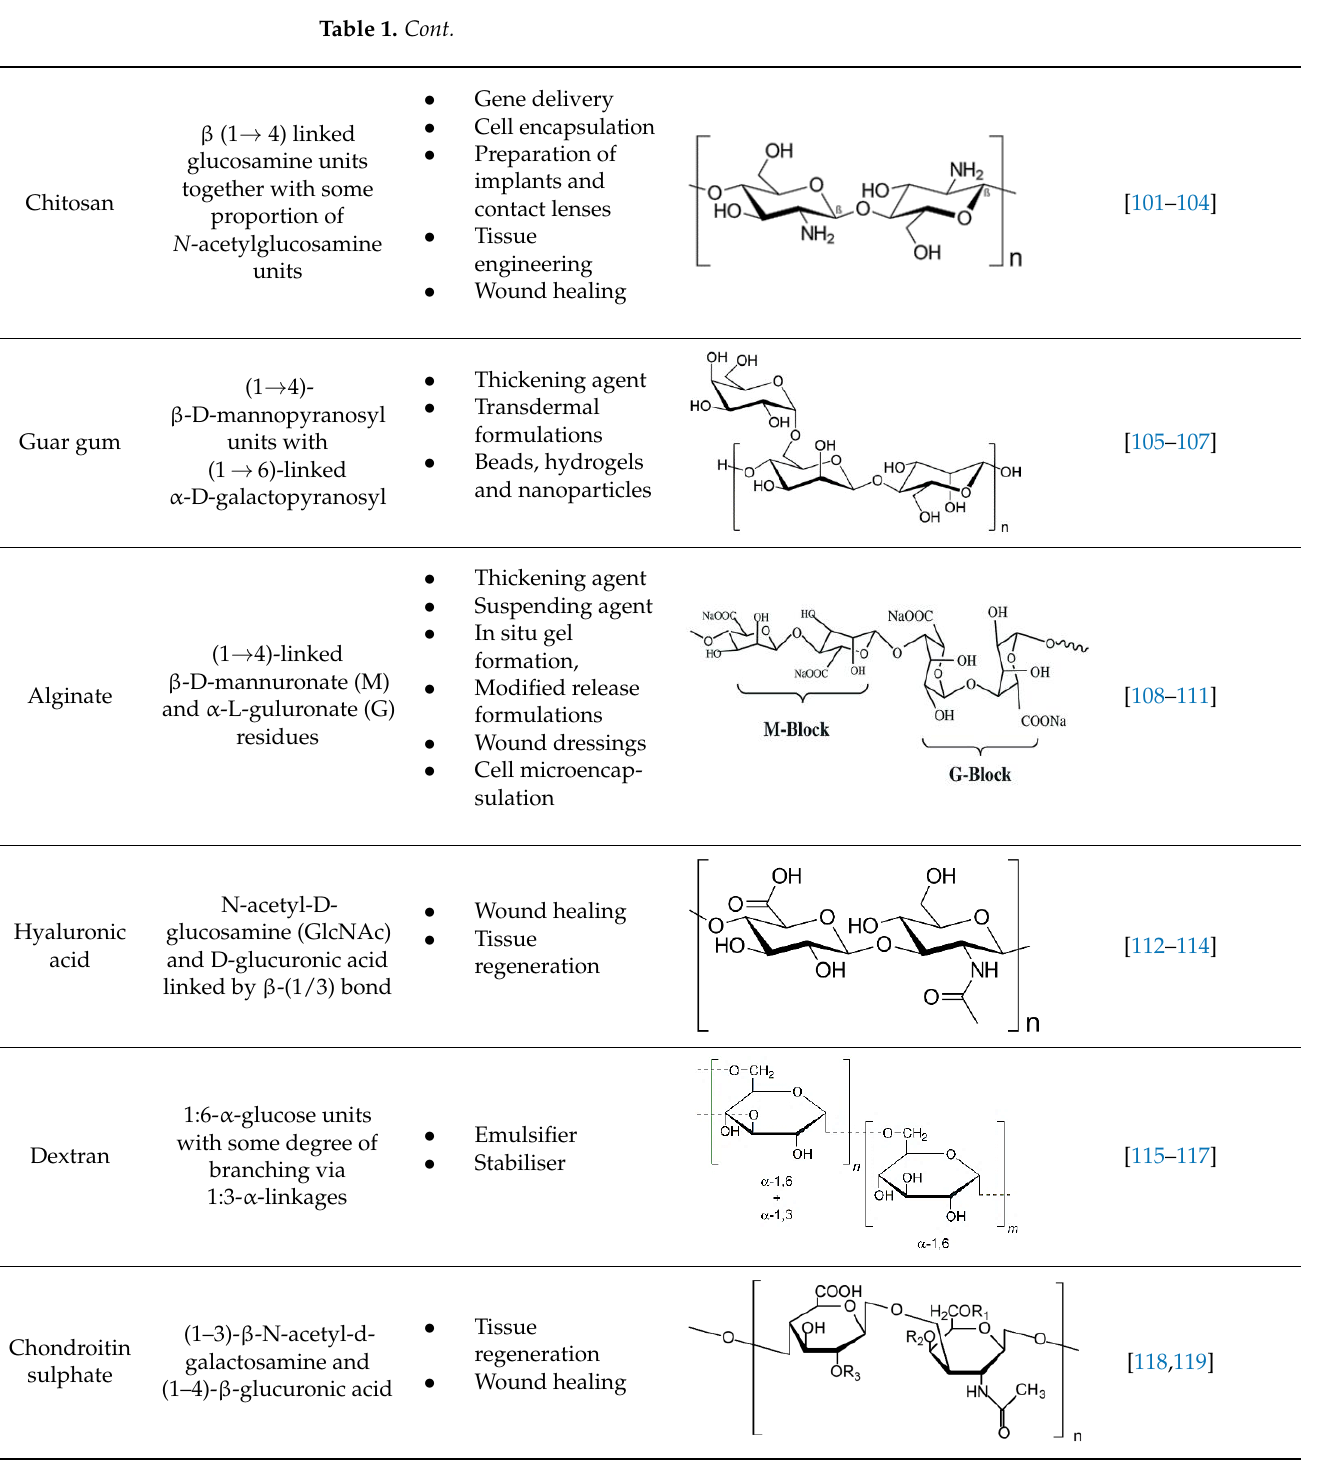
Table 1. Carbohydrate-based polymers: their structural units and pharmaceutical applications.